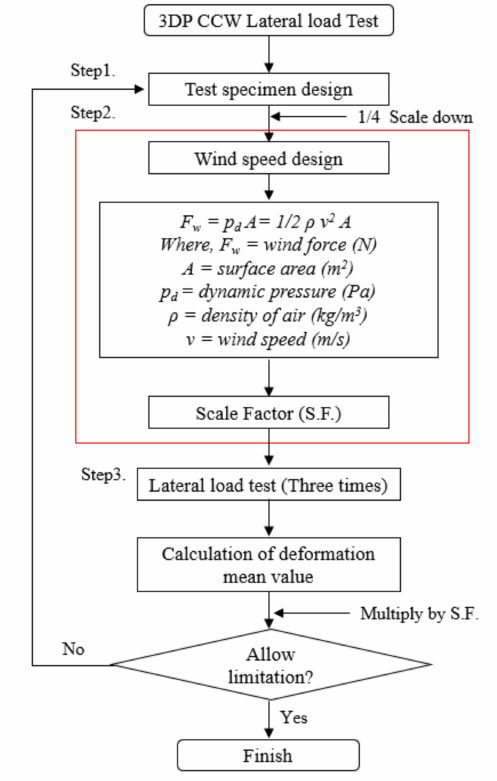
Figure 10. Process for the 3DP CCW lateral load test.